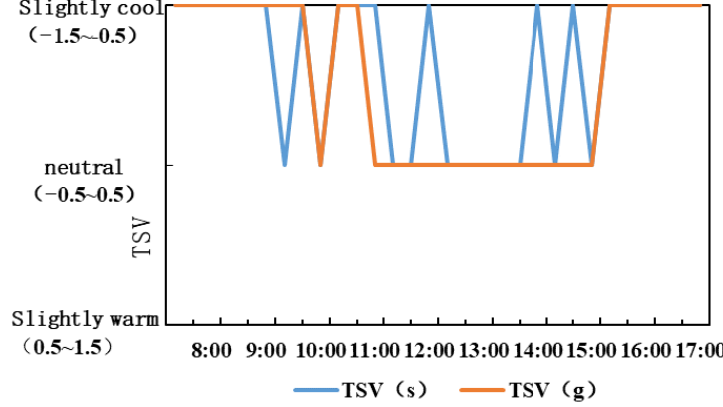
Figure 15. PET calculation results of representative day in winter.